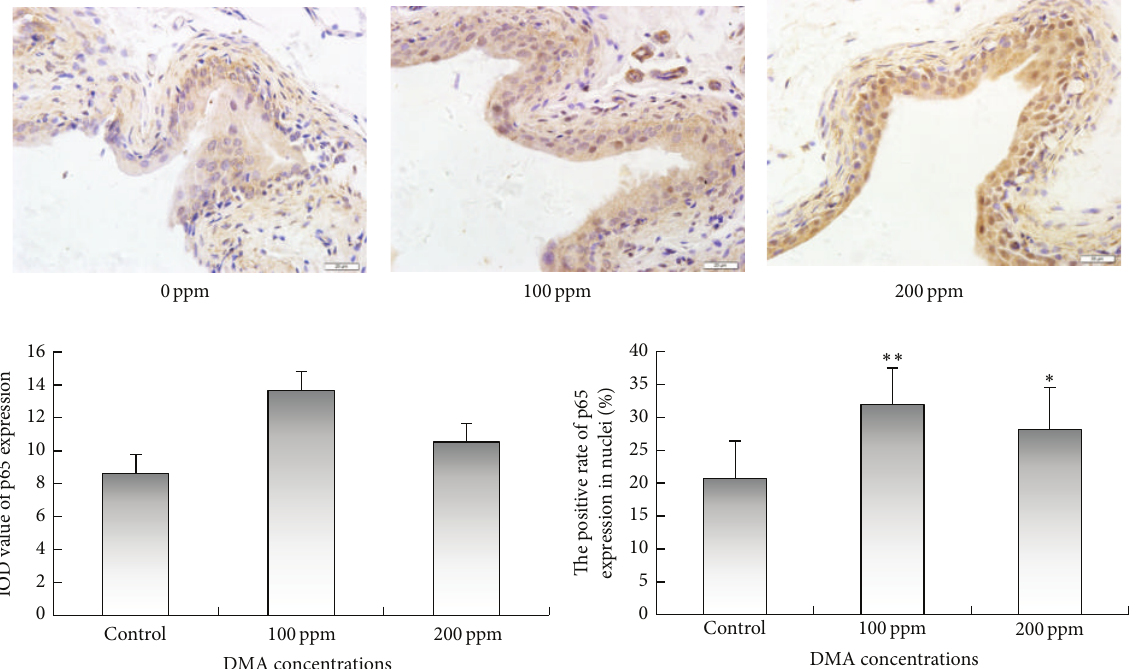
Figure 6: p65 immunohistochemical staining of bladder epithelium in DMA V treated rats. p65 expressions were presented in brown in cytoplasm and nucleus. The panel was a graphical representation of the immunohistochemical staining of p65. Bars were presented as mean ± SD. ∗ 𝑝 < 0.05 and ∗∗ 𝑝 < 0.01 compared to the control group.